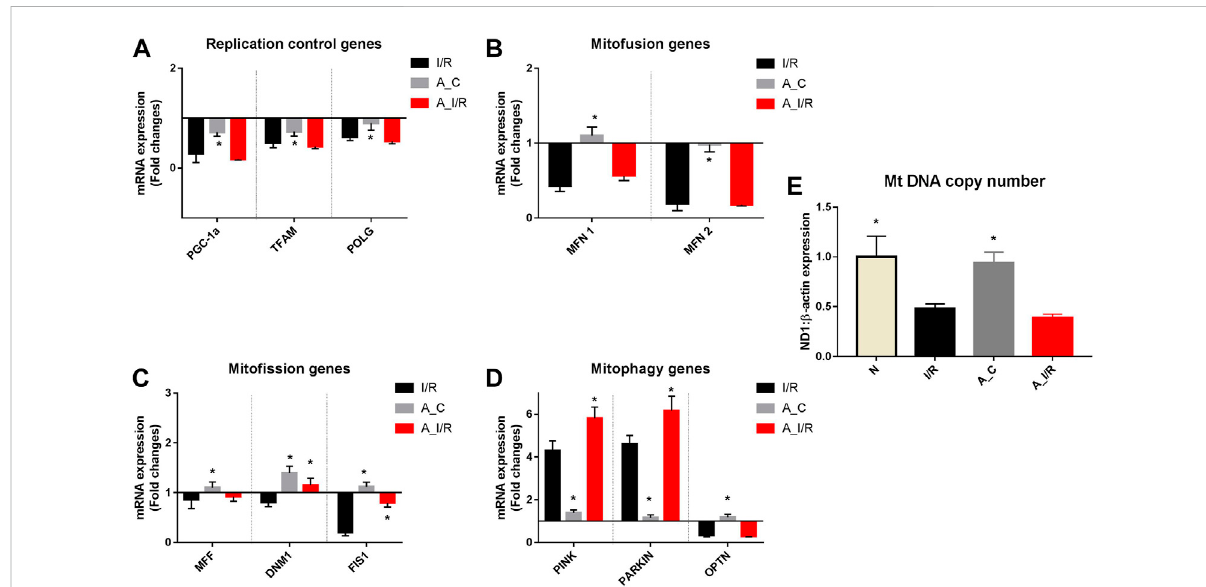
FIGURE 5 mRNA expression analysis of mitochondrial dynamics genes in I/R-challenged young and adult hearts: The mRNA expression of the genes involved inthe processes of (A) Mitochondrial replication; (B) Mitofusion; (C) Mito fi ssion; and (D) Mitophagy are presented. The values are expressed asfoldchangesfromnormal. (E) representstheendeffectormitochondrialDNAcopynumber.Thegraphsrepresentmean±SDvalues. *p < 0.05 vs. I/R